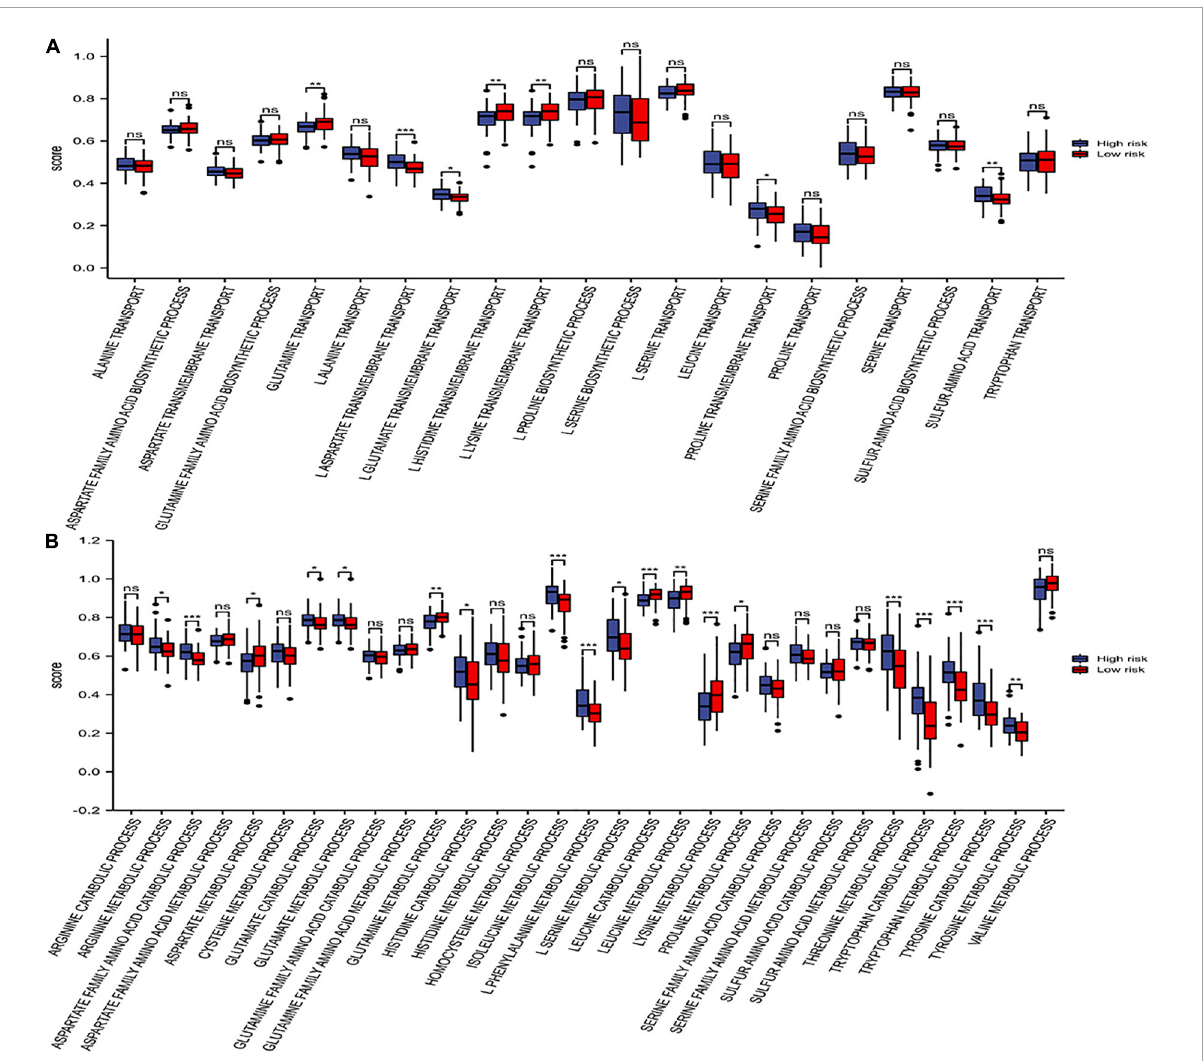
FIGURE10 Distribution of amino acid pathways. (A) The single-sample gene set enrichment analysis (ssGSEA) analysis of the amino acid synthetic and transport pathways. (B) The ssGSEA analysis of the amino acid catabolic and metabolic pathways. * p < 0.05, ** p < 0.01, *** p < 0.001, ns, no